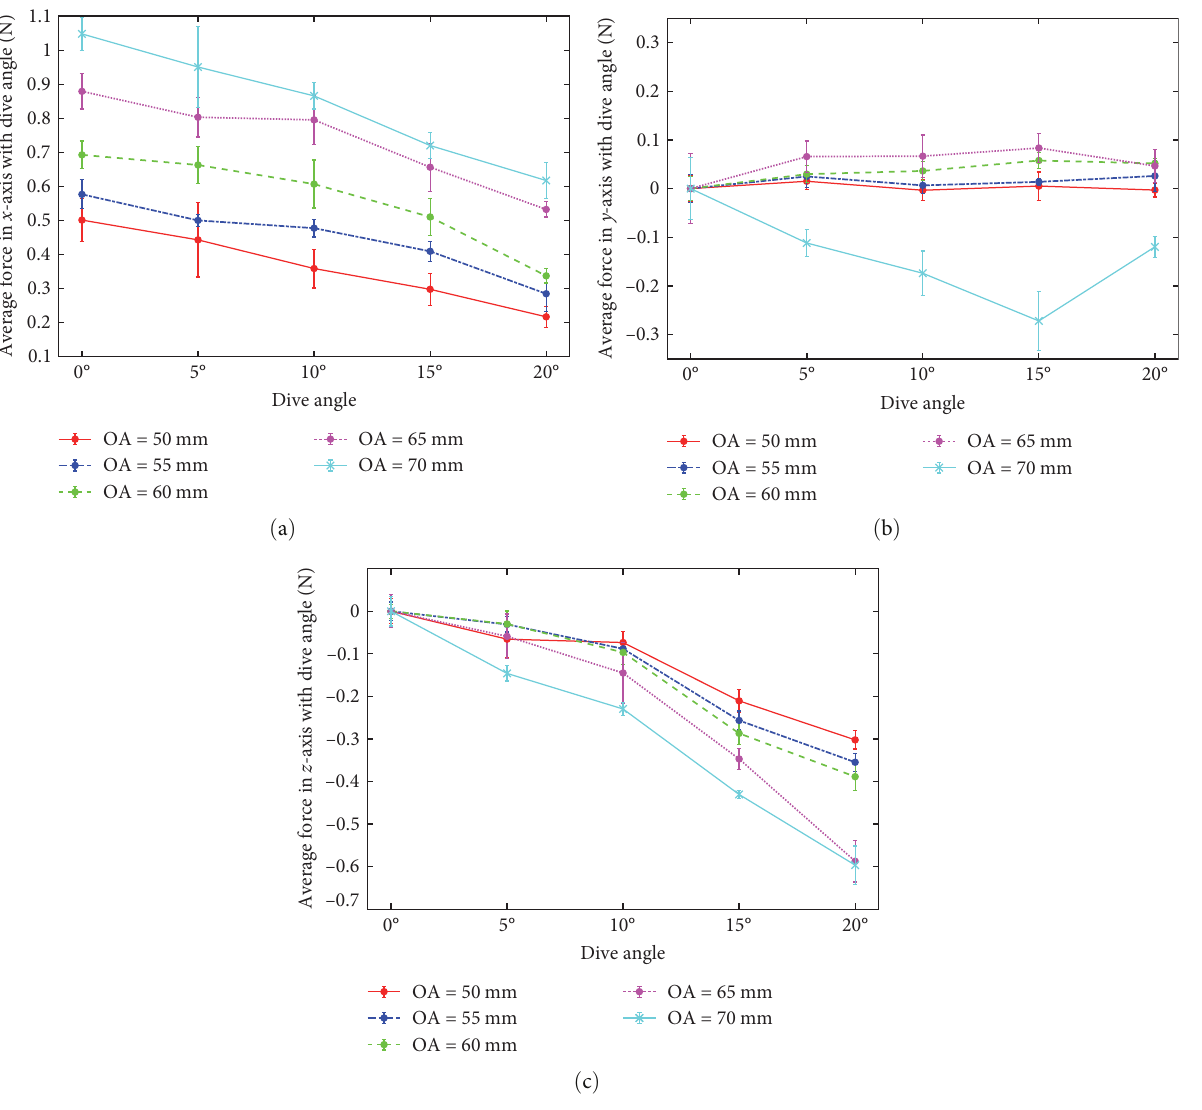
F IGURE 6: F xD ; F yD , and F zD over dive angle with no wave and no